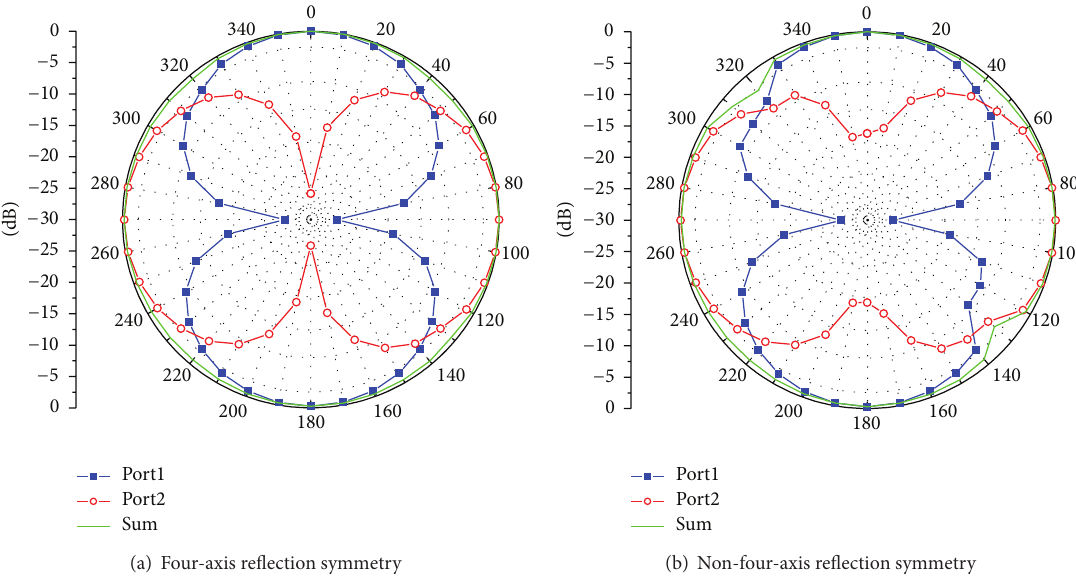
Figure 1: Radiation patterns of tag antenna with four-axis reflection symmetry and non-four-axis reflection